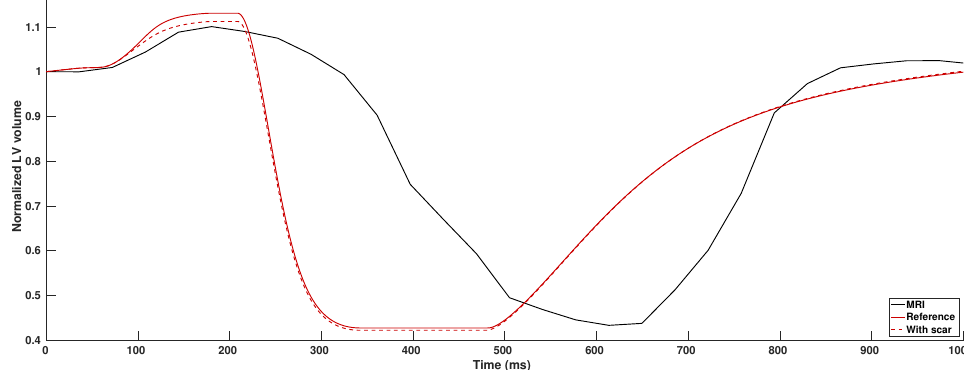
Figure 11. Left ventricular (LV) cavity volume derived from imaging data (black) and numerical simulation (red). LV volume was normalized to the maximally measured